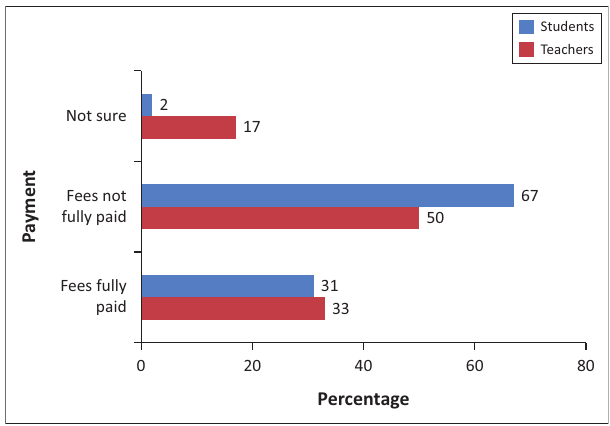
FIGURE 1: Parental migration and perception of payment of school fees and